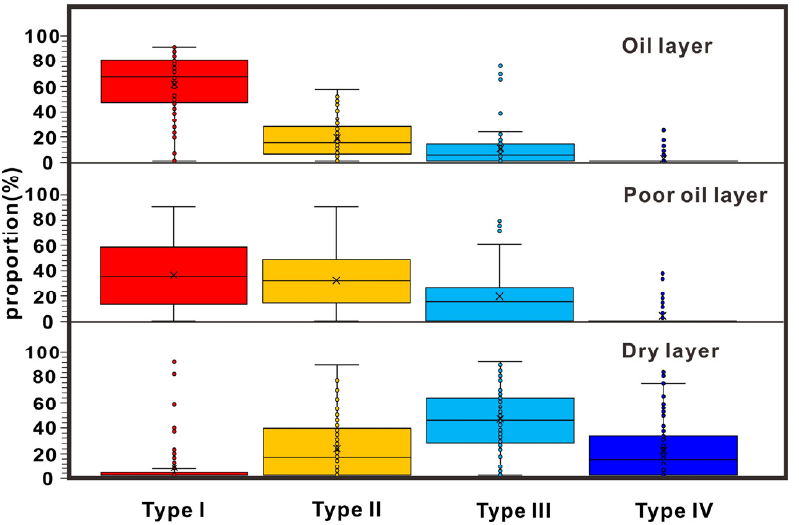
Figure 16. The proportions of various types of reservoirs in different types of oil layers (oil layer, poor oil layer, and dry layer).